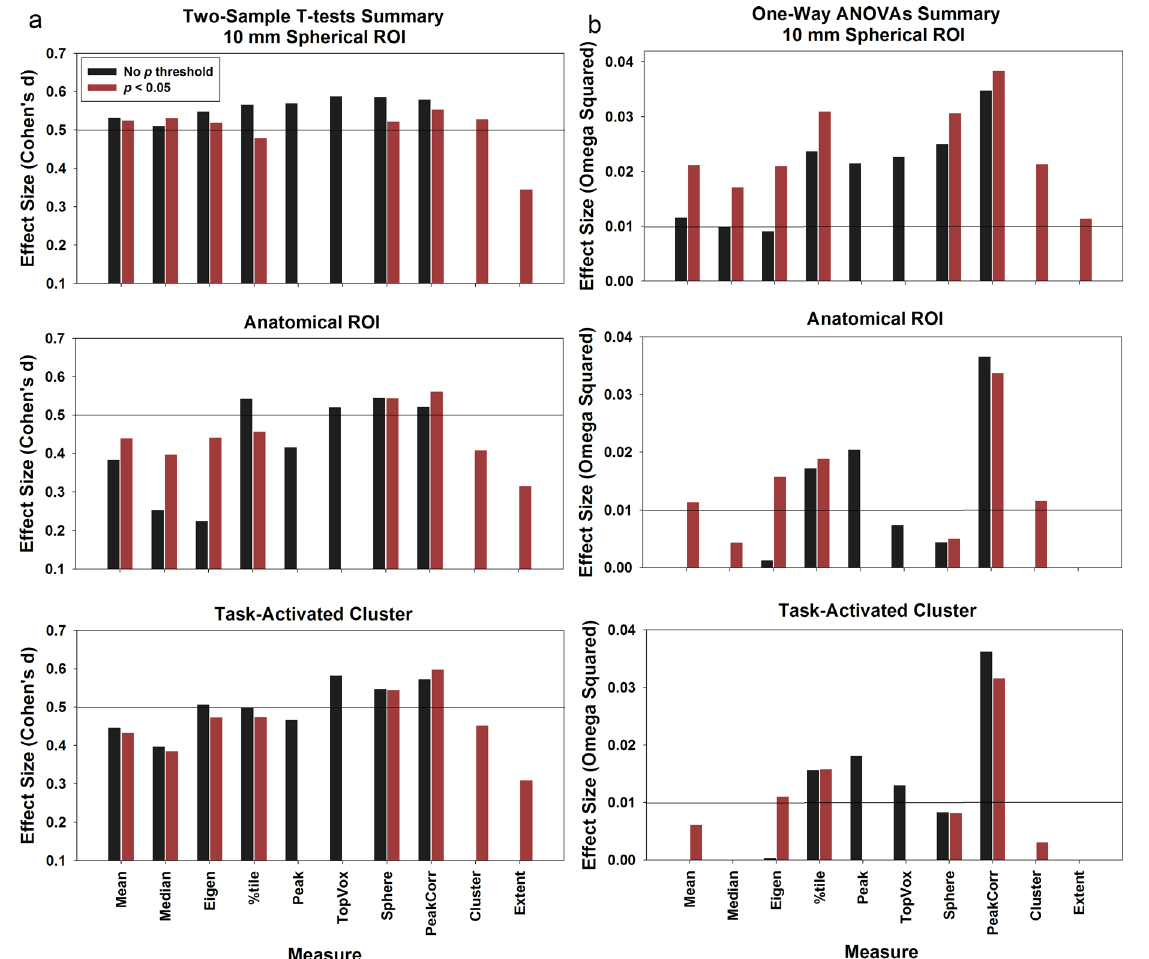
Fig 4. Results summary. We (a) combined the results of the two-sample t tests by averaging the effect sizes from dataset 1 and 4 together; and (b) combined the one-way ANOVA results by averaging the effect sizes from dataset 2 and 3. The horizontal lines in (a) represent the medium effect size (0.50) for Cohen ’ s d and the lines in (b) represent the small effect size for Omega squared